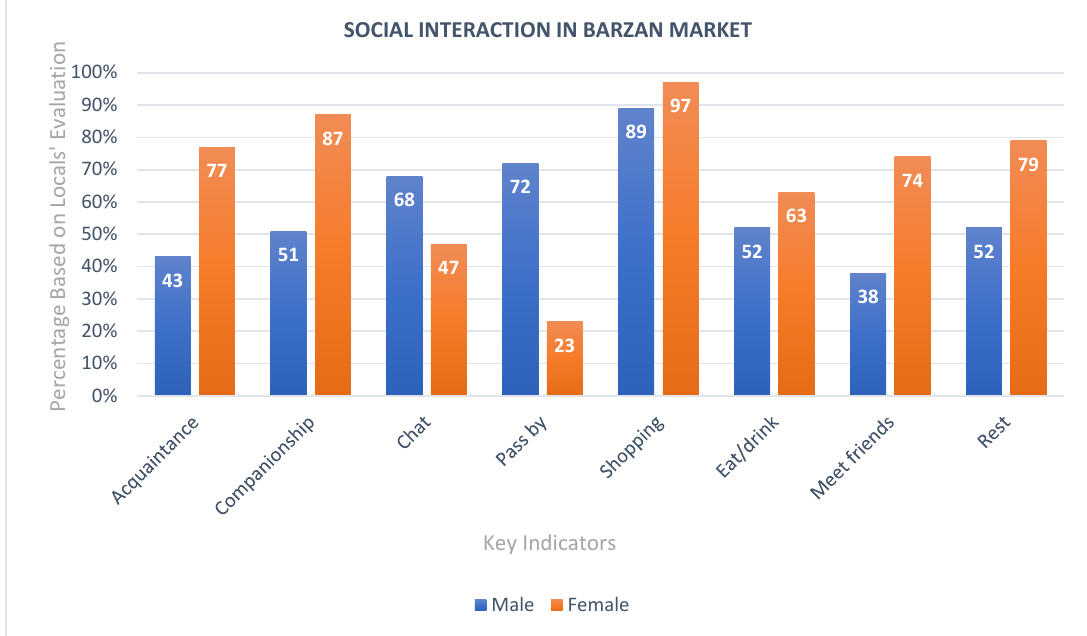
Figure 12. Social interaction